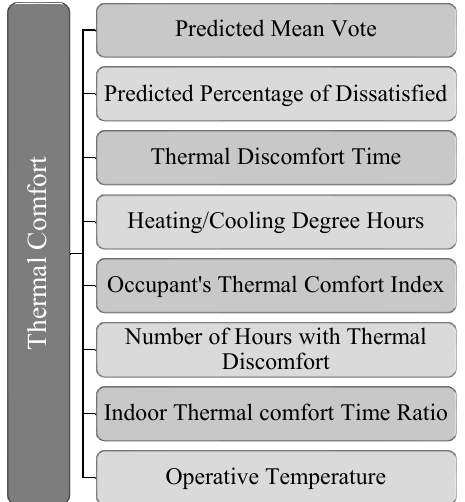
Figure 6. Thermal comfort indicators.